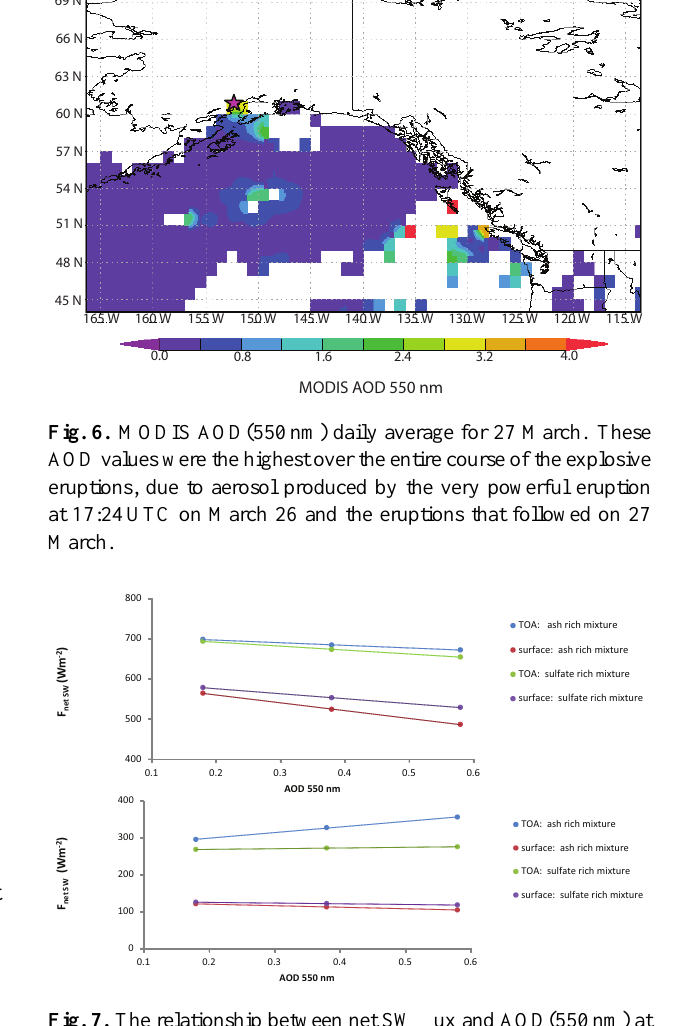
Fig. 7. The relationship between net SW flux and AOD(550nm) at an AOD range of 0.18–0.58 for two aerosol mixtures at the TOA and surface over seawater (top panel) and snow (bottom panel). SZA is 55 ◦ . The R 2 regressions for all lines are greater than